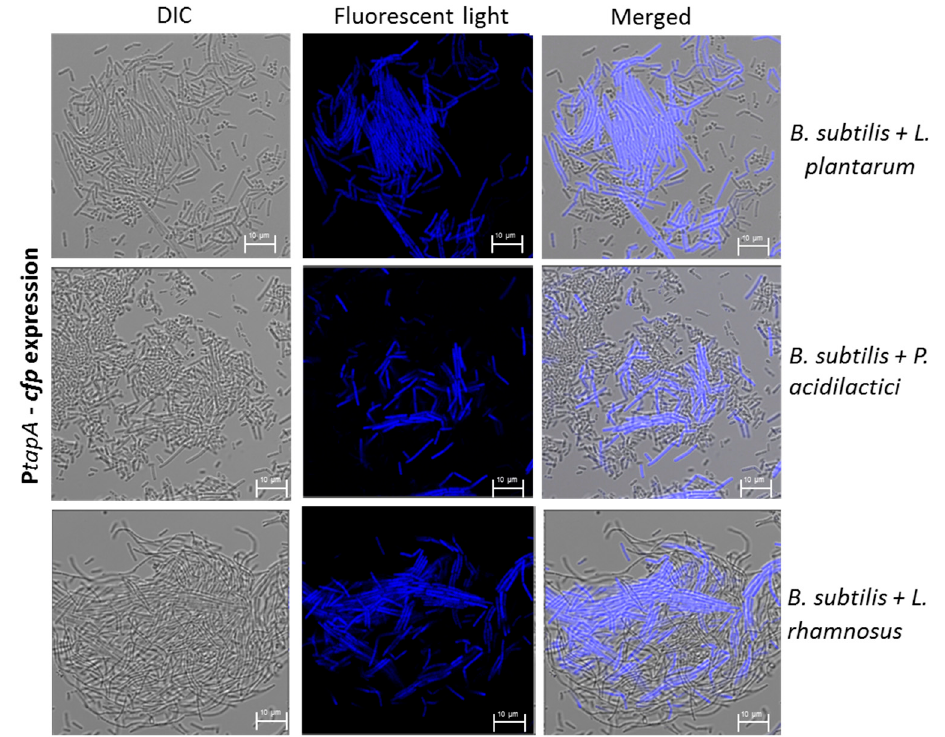
Figure 1. Formation of dual-species biofilm bundles of B. subtilis with LAB. Bacterial biofilms were generated during co-culture growth of B. subtilis cells with either Lactobacillus plantarum , Pediococcus acidilactici , or L. rhamnosus cells in modified MRS (MMRS) medium at 37 °C for 8 h. The biofilm samples were prepared as described in Section 2 and analyzed using a confocal laser scanning microscope (CSLM, Leica, Germany). B. subtilis cells express CFP under the control of the tapA operon, which is responsible for the matrix production. LAB cells are not stained. Scale bar = 10 µm.